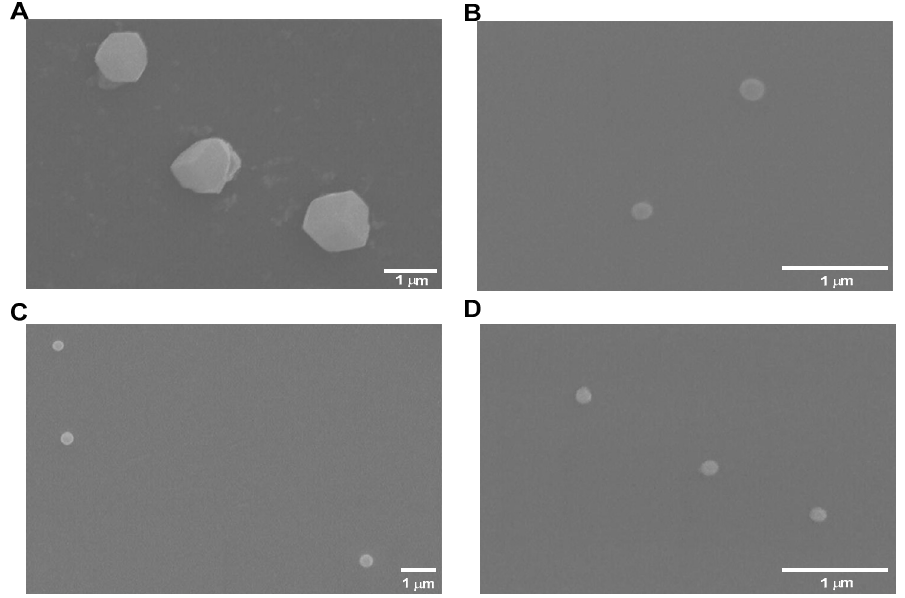
Figure 2. Selected images obtained by SEM for ( A ) SBE- β -CD/quercetin inclusion complexes; ( B ) HMW chitosan/SBE- β -CD/quercetin delivery systems; ( C ) LMW chitosan/SBE- β -CD/quercetin delivery systems; and ( D ) 5 kDa chitosan/SBE- β -CD/quercetin delivery systems.